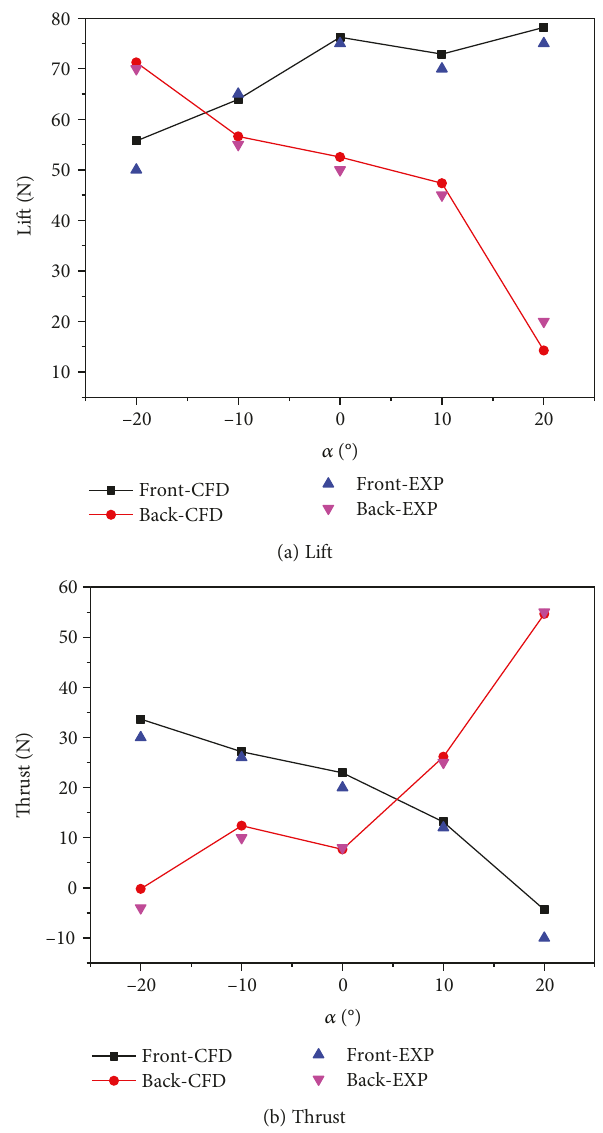
Figure 23: Comparison curves between numerical results and experimental results when the front and rear wings have the same installation